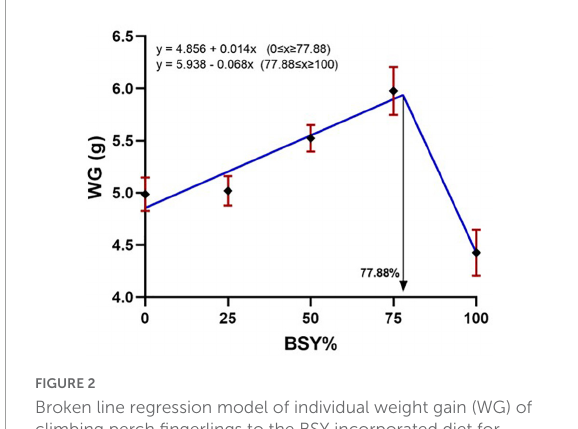
FIGURE2 Broken line regression model of individual weight gain (WG) of climbing perch fingerlings to the BSY incorporated diet for 60 days. The X-axis represents the gradient inclusion levels of BSY in the place of fishmeal. The values are expressed as Mean ± SD, n =